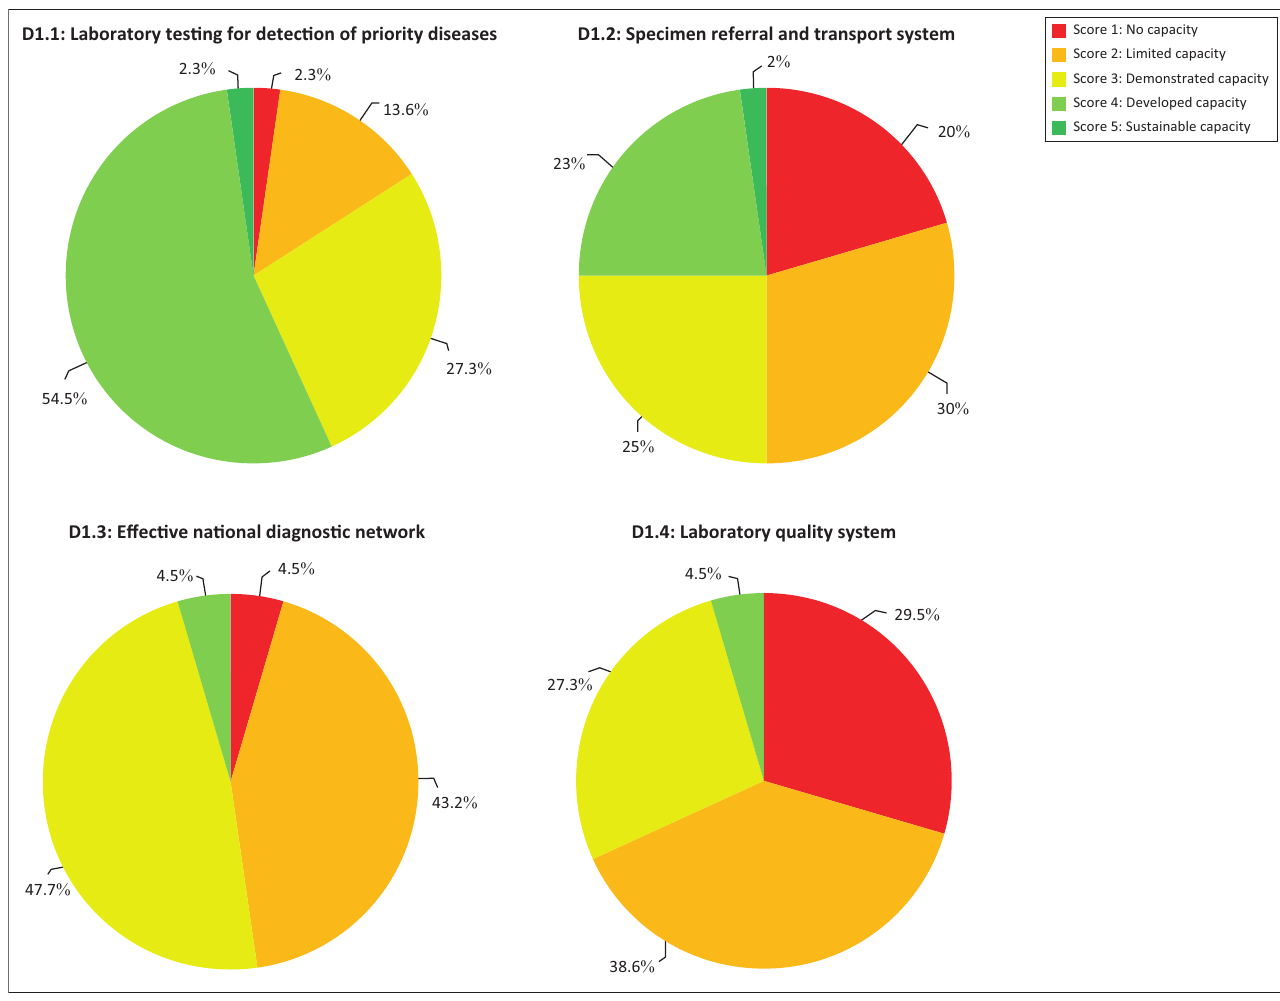
FIGURE 1: Proportion of African countries ( N = 54) at various levels of capacity in the area ‘laboratory network’ of the Joint External Evaluation